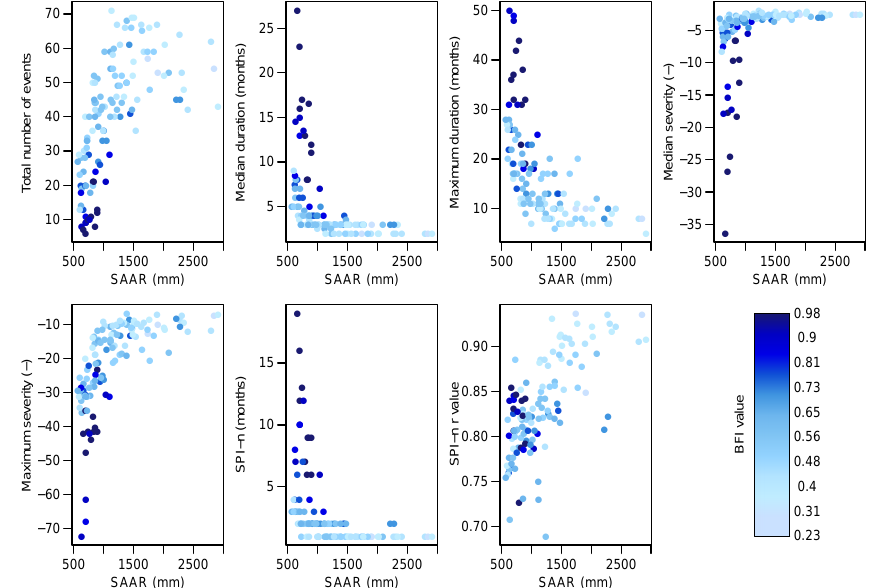
Figure 11. Relationship between hydrological drought characteristics based on SSI-1 using a threshold of − 1 and SAAR for all catchments.